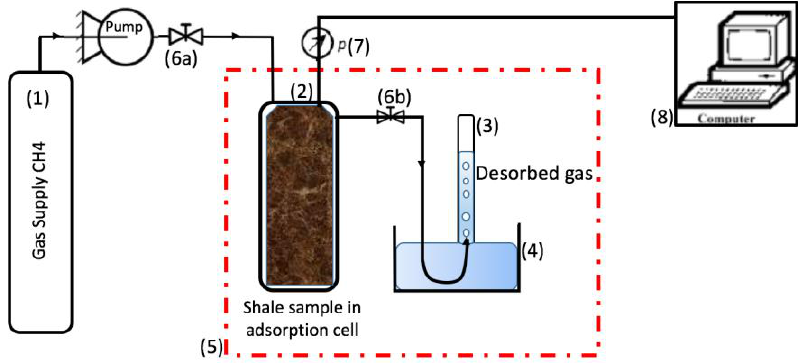
Figure 1. Experimental set-up for the desorption measurement, the labeled components: (1) methane gas cylinder, (2) adsorption cell, (3) 1000 mL inverted graduated tube, (4) water container, (5) thermostat, (6) controlling valves, (7) pressure gauge, and (8) computer.